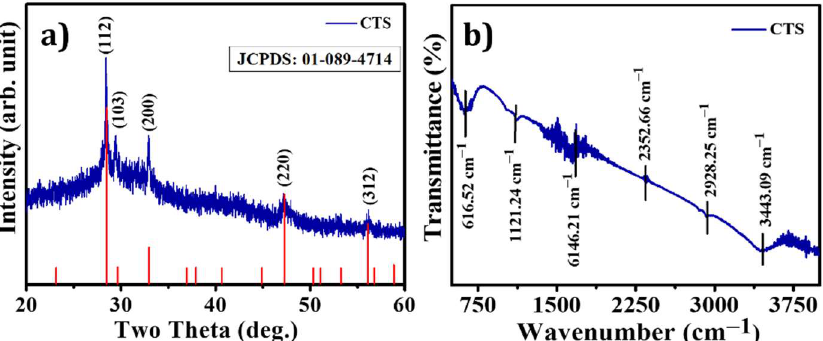
Figure 2. ( a ) X-ray diffraction pattern, ( b ) FTIR spectrum of CTS NPs.